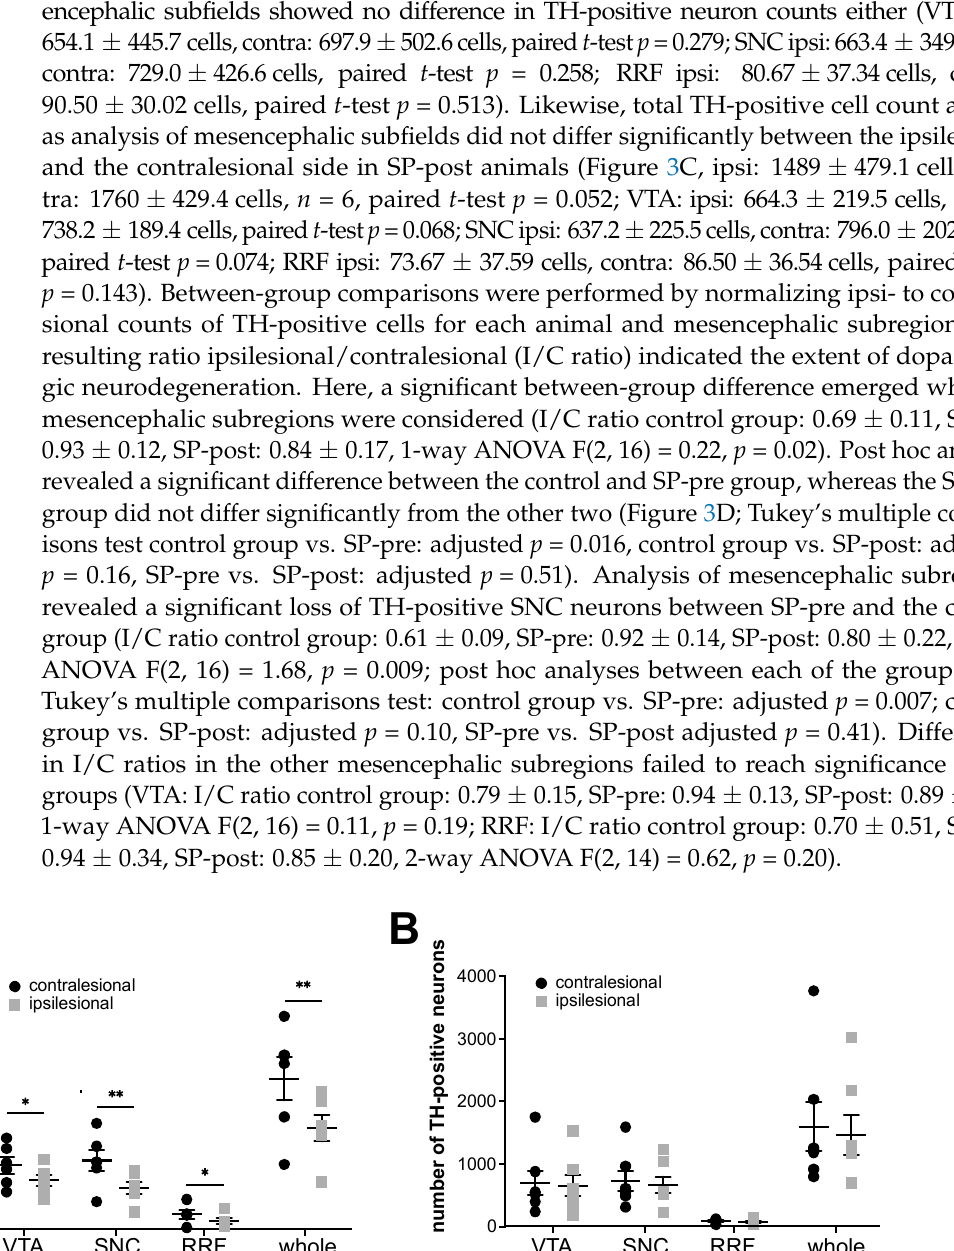
Figure 3. Dopaminergic neurodegeneration after stroke is attenuated by Substance P. ( A ) Intrain- dividual comparison of TH-positive neuron counts between contra- and ipsilesional hemisphere revealed ipsilesional neuron loss in control animals. ( B , C ) In SP-pre and SP-post animals, no ipsi- lesional dopaminergic degeneration was observed. ( D ) Between-group comparisons of ipsile- sional/contralesional TH-positive cell count ratios revealed significant differences between groups for the whole hemisphere and SNC. ( E ) Representative light-microscopy images (10× magnifica- tion) indicate bilateral midbrain TH-immunoreactivity 15 days after stroke induction. Please note the obvious loss of TH-positive neurons within the ipsilesional SNC of a control rat. Scale bar: 100 µm. RRF: retrorubral field, SNC: substantia nigra pars compacta, VTA: ventral tegmental area. * p < 0.05, ** p < 0.01. Data are presented as mean ± SEM.